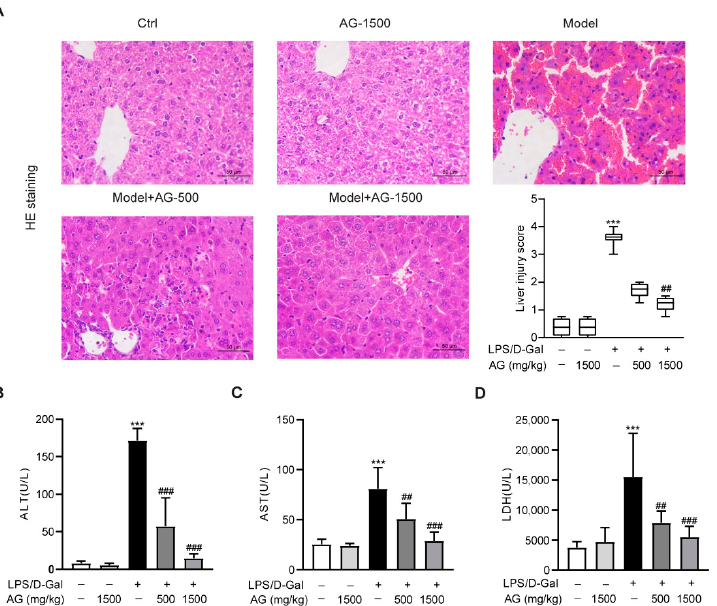
Figure 1. Effects of Ala-Gln on LPS/D-Gal-induced hepatic pathological and biochemical parameters in mice. ( A ) Liver tissues were stained with HE for histopathological analysis (original magnifications, × 400), and the degree of liver injury was scored. ( B – D ) plasma ALT, AST, and LDH levels. Data A is presented as medians with interquartile range. Data B–D are expressed as mean ± SD; n = 6–8 in each group. *** p < 0.001 vs. vehicle ‐ treated control group, ## p < 0.01, ### p < 0.001 vs. LPS/D ‐ Gal ‐ treated model group.